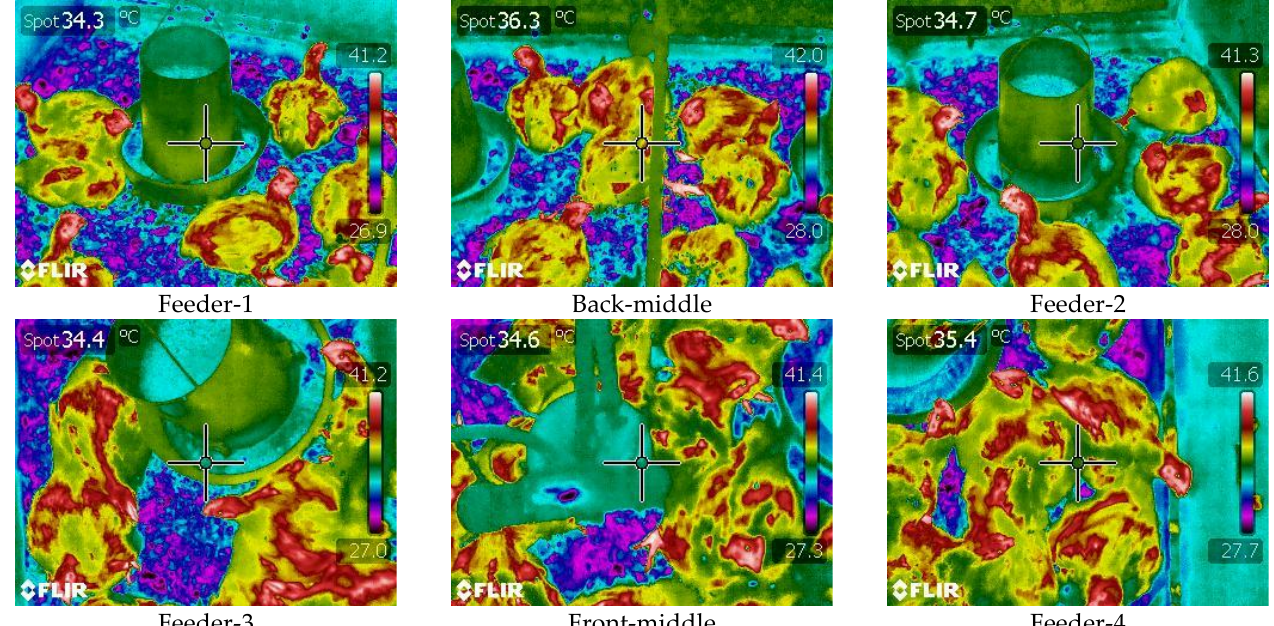
Figure 2. Thermal images by segments in a chamber. Feeder-1, back-middle and feeder-2 were captured in the outlet of the chamber and feeder-3, front-middle and feeder-4 were captured from the inlet of the chamber (see Figure 1 for feeder’s relative locations).